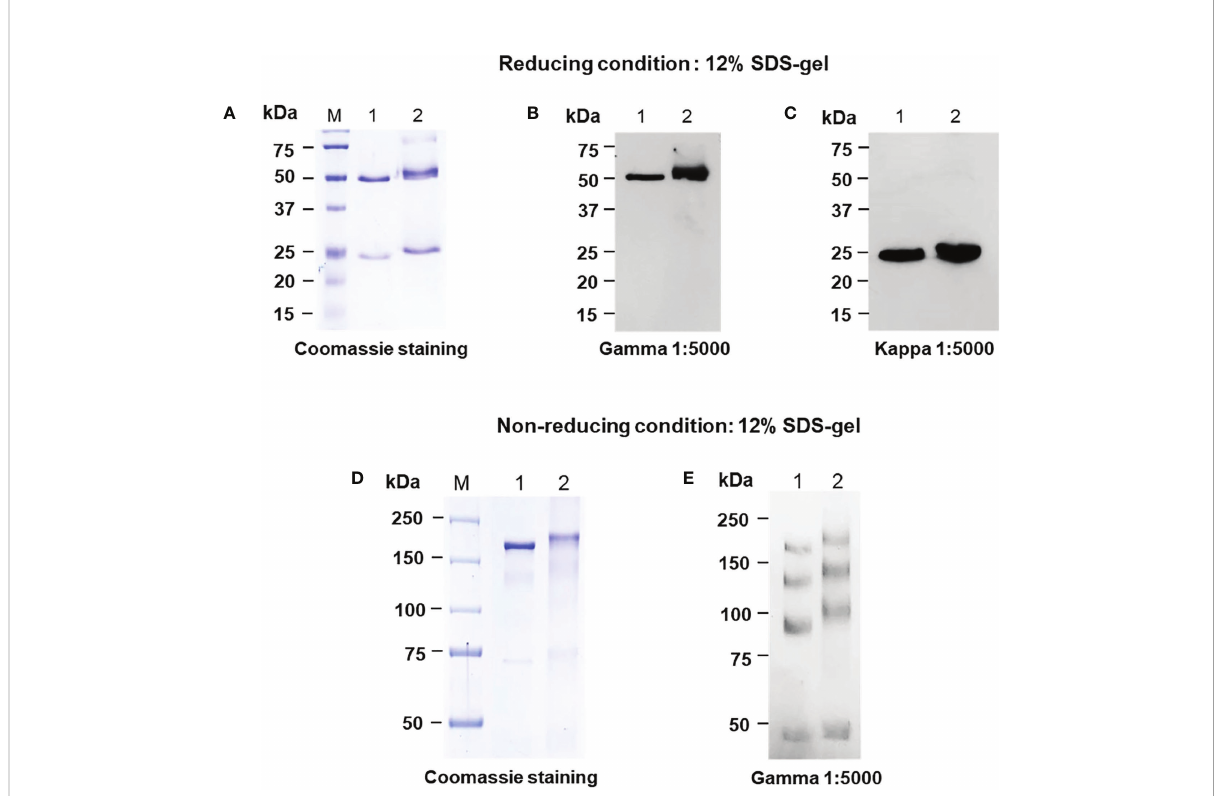
FIGURE 2 SDS-PAGE analysis of the puri fi ed plant-produced anti-human IgE antibody in Nicotiana benthamiana under reducing and non-reducing conditions using SDS-PAGE (A, D) and Western blot analysis with either HRP-conjugated goat anti-human gamma chain antibody (B, E) or goat anti-human kappa chain antibody (C) . 150-450 ng of the plant puri fi ed protein and commercial Omalizumab was loaded in the well. Lane M: Protein ladder, Lane 1: Commercial Omalizumab (Xolair), Lane 2: Puri fi ed plant-produced anti-human IgE antibody.